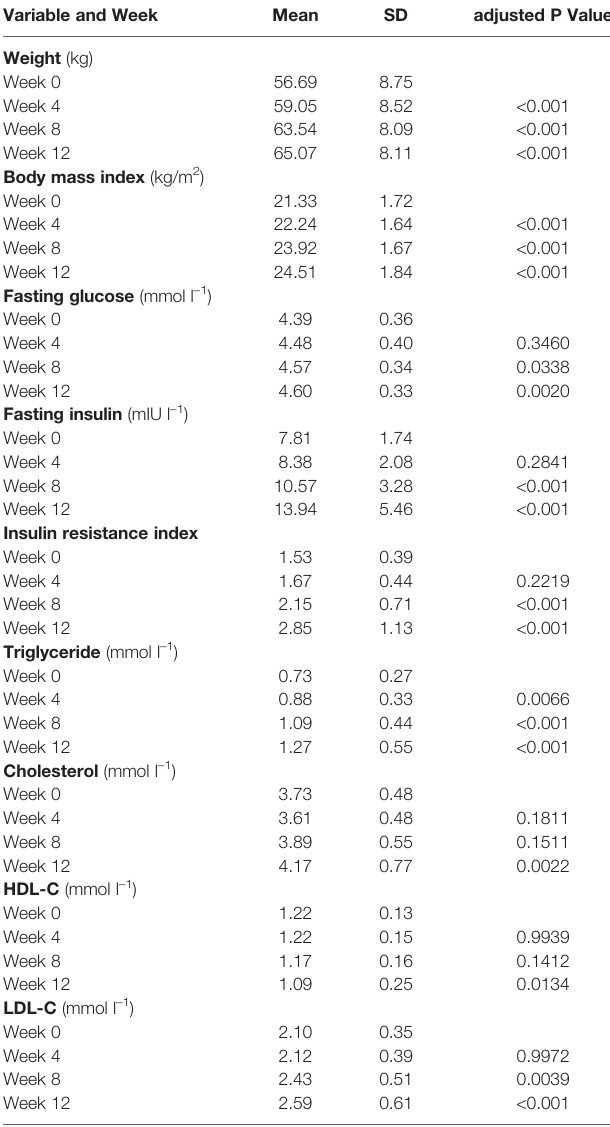
TABLE 1 | Summary of weight and metabolic measures by study. Variable and